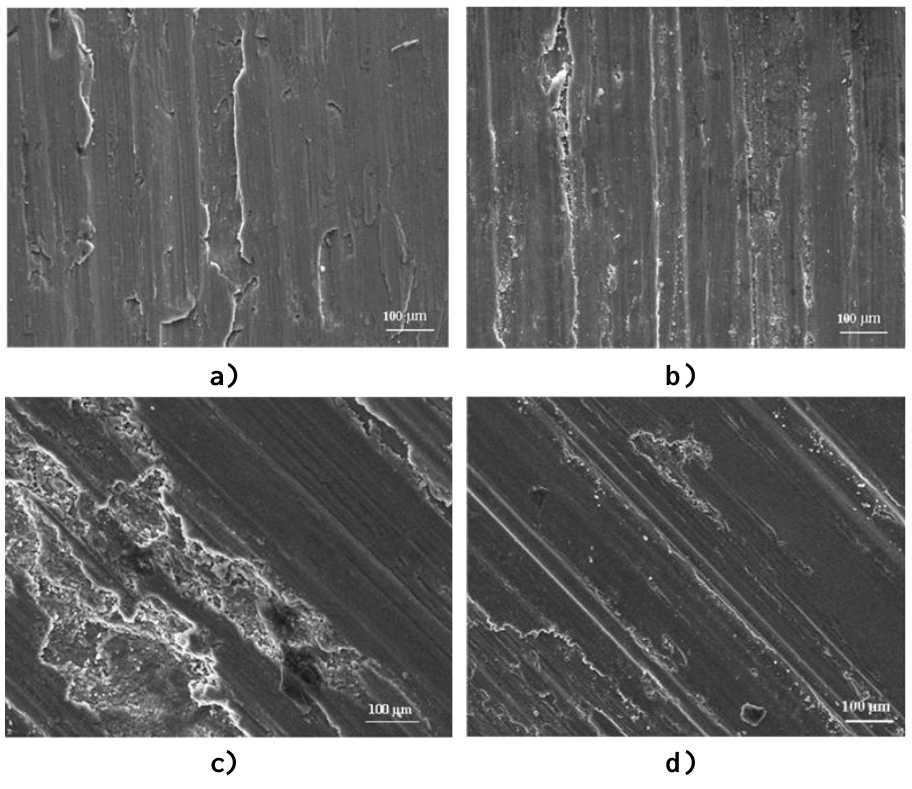
Fig. 9. Micrograph worm out surfaces: a) Al alloy + 3% Al 2 O 3 + 2% E-glass at 10 N and sliding distance 500 m, b) Al alloy + 6% Al 2 O 3 + 4% E-glass at 20 N and sliding distance 1000 m, c) Al alloy + 9% Al 2 O 3 + 6% E-glass at 30 N and sliding distance 1500 m, d) Al alloy + 9% Al 2 O 3 + 6% E-glass at 20 N and sliding distance 1500